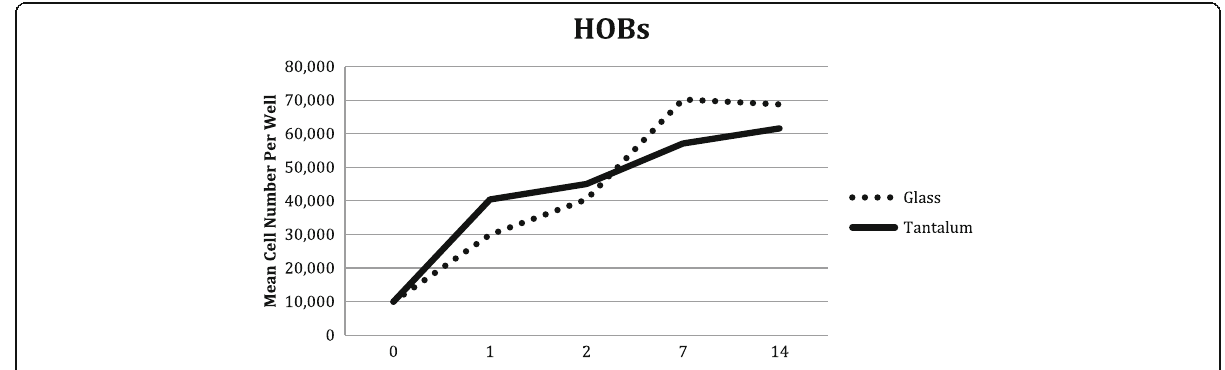
Fig. 1 Human Osteoblast (HOBs) proliferation on glass and tantalum-coated glass substrates at 0, 1, 2, 7 and 14 days culture